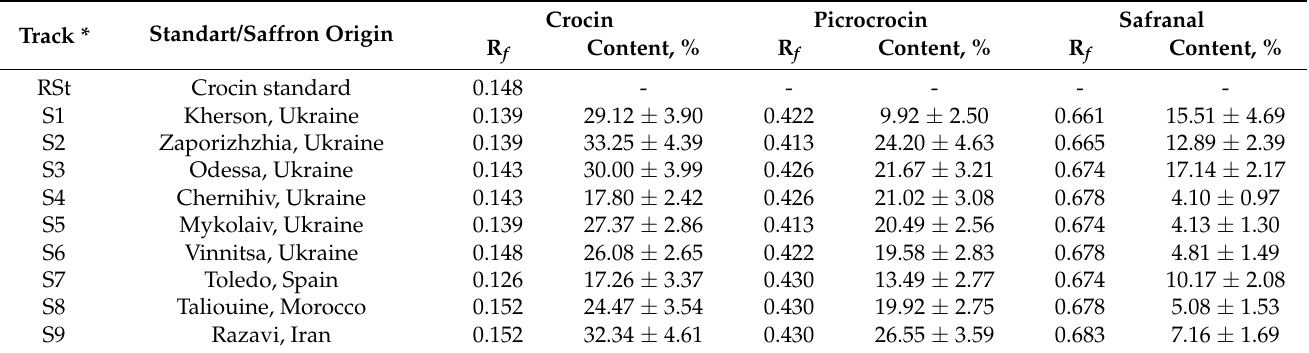
Table 1. The amount of main compounds (%) in the methanolic saffron extracts. Track *